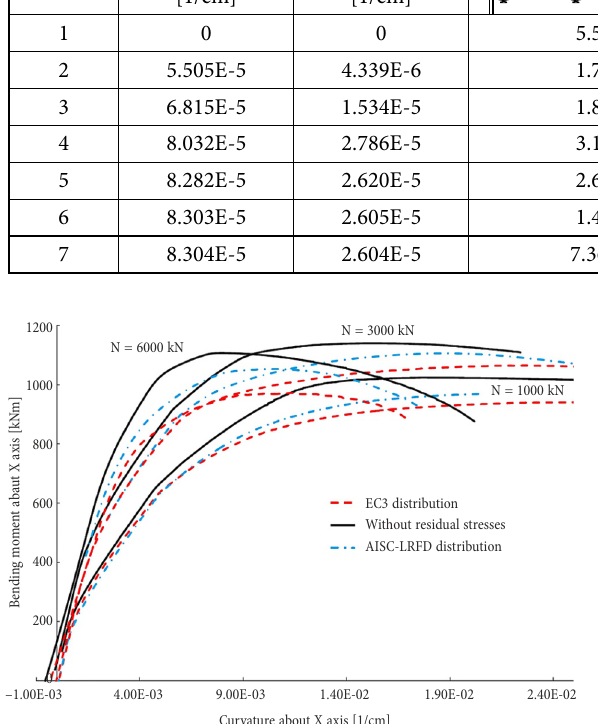
Table 2. Main parameters involved in the iterative process ( N = 6000 kN; reference strain e Curvature about Iteration z-axis f z [1/cm]